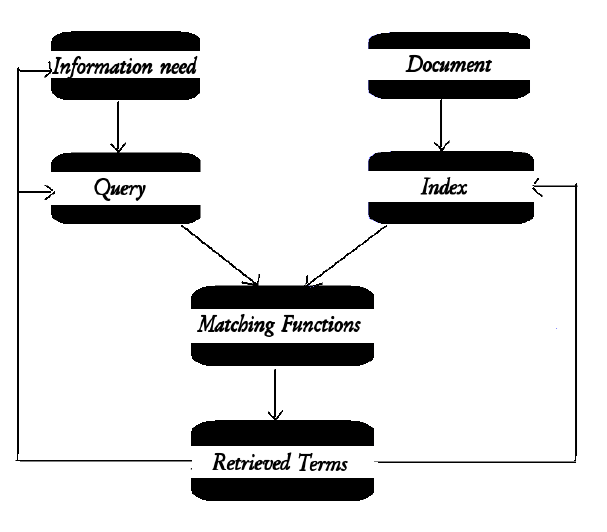
Figure 1 . Visualization of Information Retrieval system